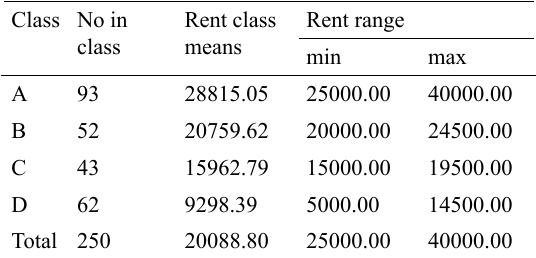
Table 3. Rent-interval classi fi cation